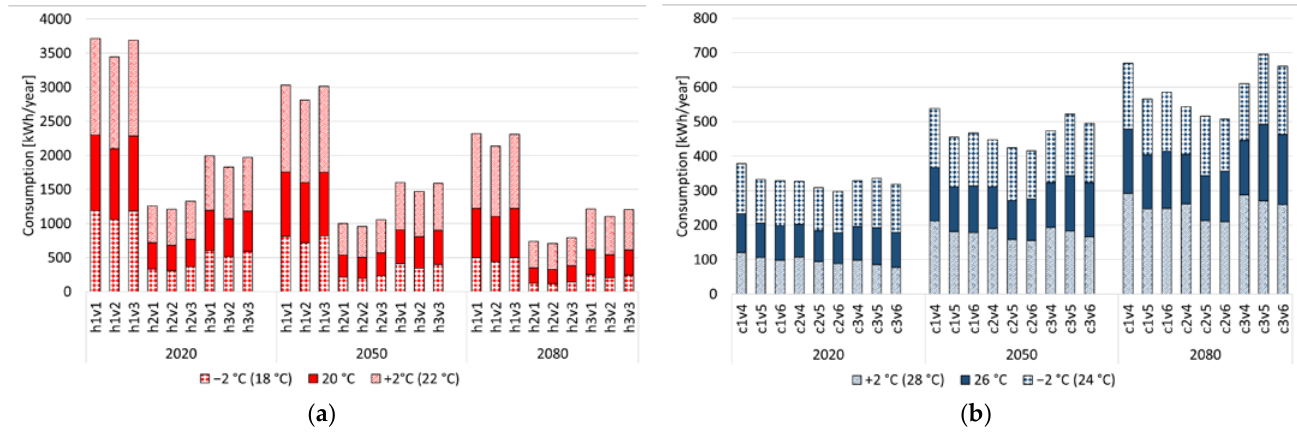
Figure 10. Energy consumption [kWh/year] by varying the setpoint temperatures of ±2 °C for ( a ) heating; and ( b ) cooling.